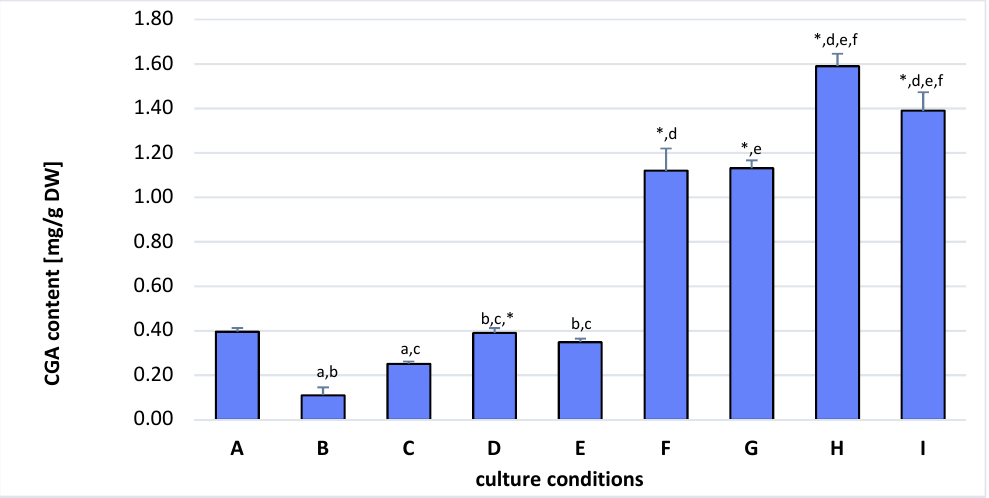
Figure 5. Chlorogenic acid (CGA) content [mg/g DW] determined in hairy roots of K-1 line cultivated under various conditions: ( A ) control roots collected after 10 days of culture; ( B ) control roots collected after 20 days of culture; ( C ) control roots collected after 30 days of culture; ( D ) control roots collected after 40 days of culture; ( E ) control roots collected after 50 days of culture; ( F ) hairy roots elicited for 3 days with 50 µM MeJA; ( G ) hairy roots elicited for 7 days with 100 µM MeJA; ( H ) hairy roots elicited for 1 day with 100 µM MeJA 100 and then transferred to control medium for 30 day cultivation; ( I ) hairy roots elicited for 7 days with 100 µM MeJA 100 and then transferred to control medium for 30 day cultivation. Means denoted with the same letter or asterisks are statistically significant ( p < 0.05).